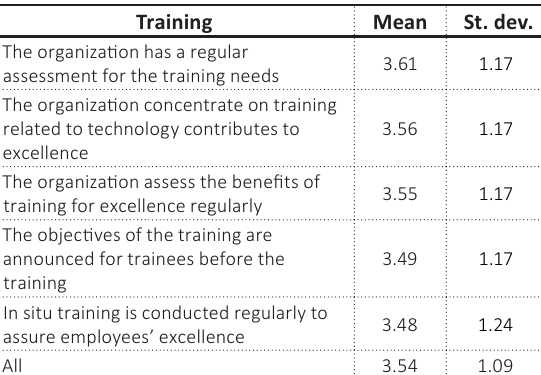
Table 3. Managers’ attitudes for the role of SHRM training component toward excellence